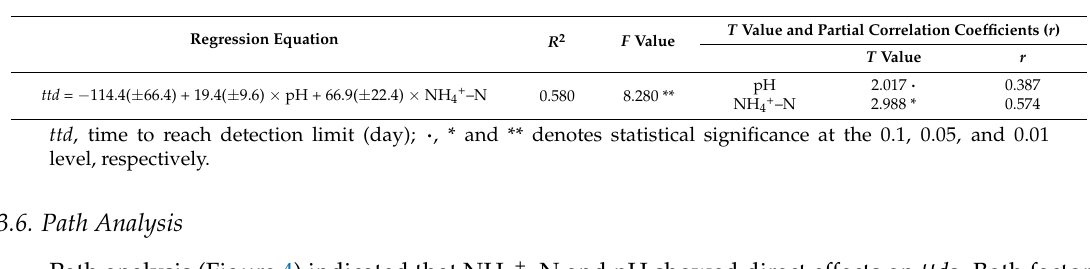
Table 2. Stepwise multi-regression analysis of water properties and survival time ( ttd ) of S. Typhimurium in well water samples.